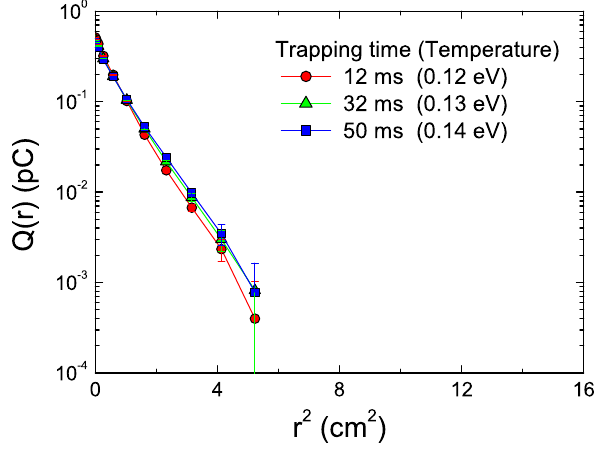
FIG. 3. (Color) Measured radial profiles of trapped plasma with- out applied noise. The charge bunch is maintained in the qua- siequilibrium state for about 38 ms with a slight increase in the effective transverse temperature [calculated from Eq. (3)]. A straight line in the log of Q ð r Þ versus r 2 plot indicates that the radial profile is a Gaussian function of r